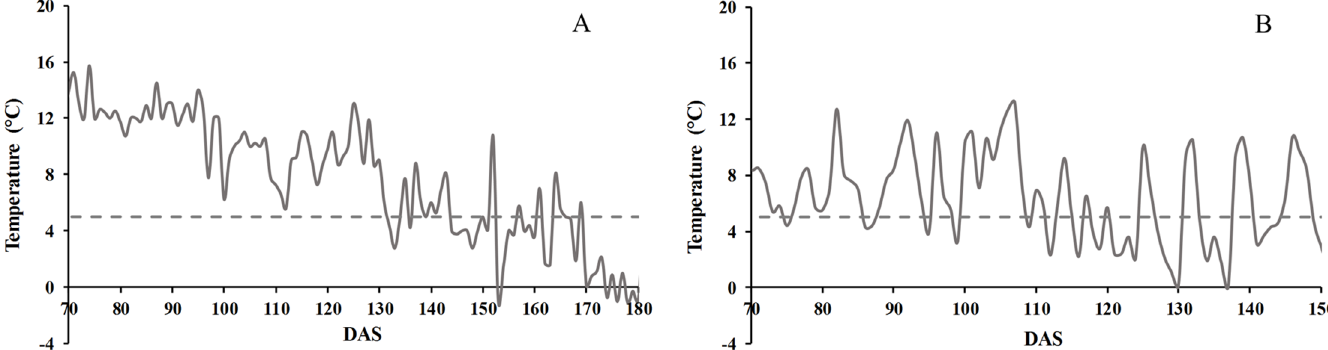
Fig 2. Variation of the minimum temperature from flowering to harvest in Antumapu (A, 2011) and Intihuasi (B, 2014). (DAS = days after sowing). Dashed line indicates the temperature threshold below which the plant begins to present damage.